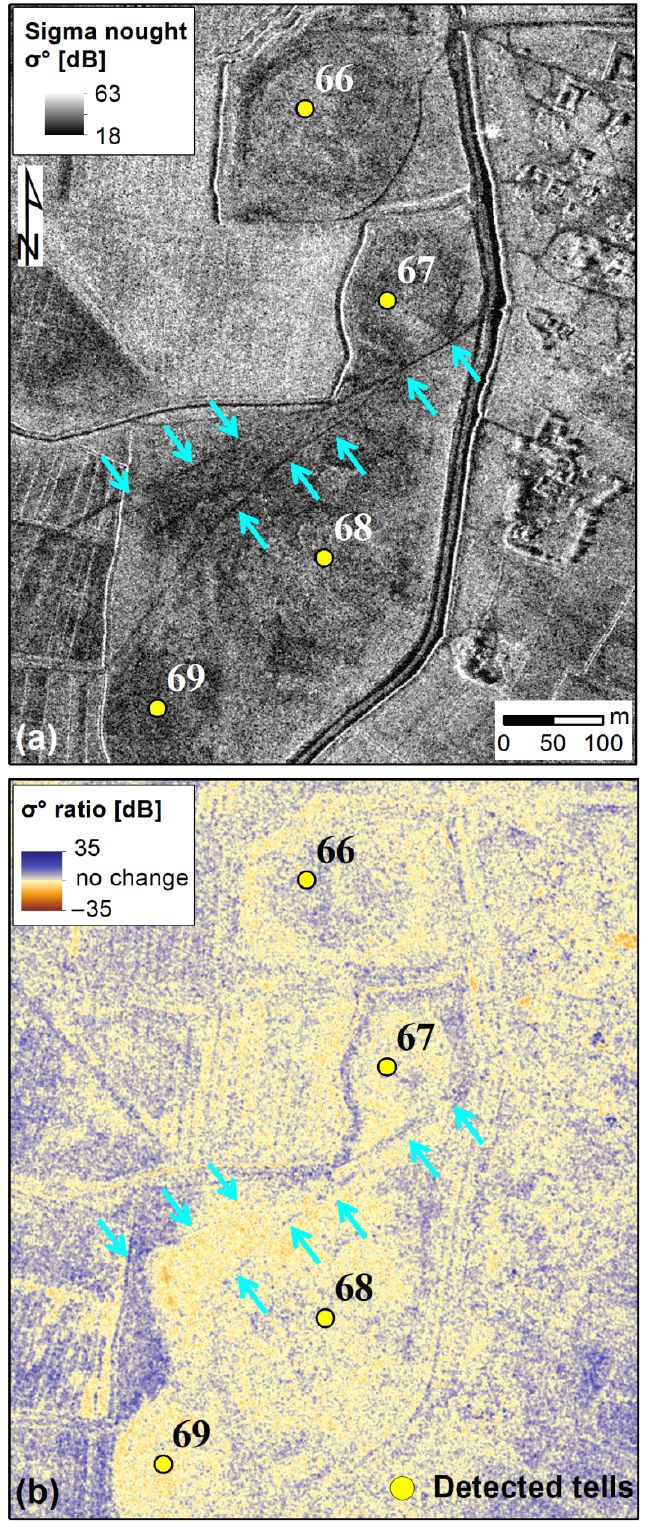
Figure 15. ( a ) Multi-temporal average COSMO-SkyMed Enhanced Spotlight image (27 July 2019–24 March 2020) of detected tells in which Google Earth imagery showed evidence of looting. ( b ) COSMO-SkyMed amplitude change detection map (2019–2020) suggests a differential impact of anthropogenic disturbance between the sites. COSMO-SkyMed ® Products ©ASI, Italian Space Agency, 2019–2020.